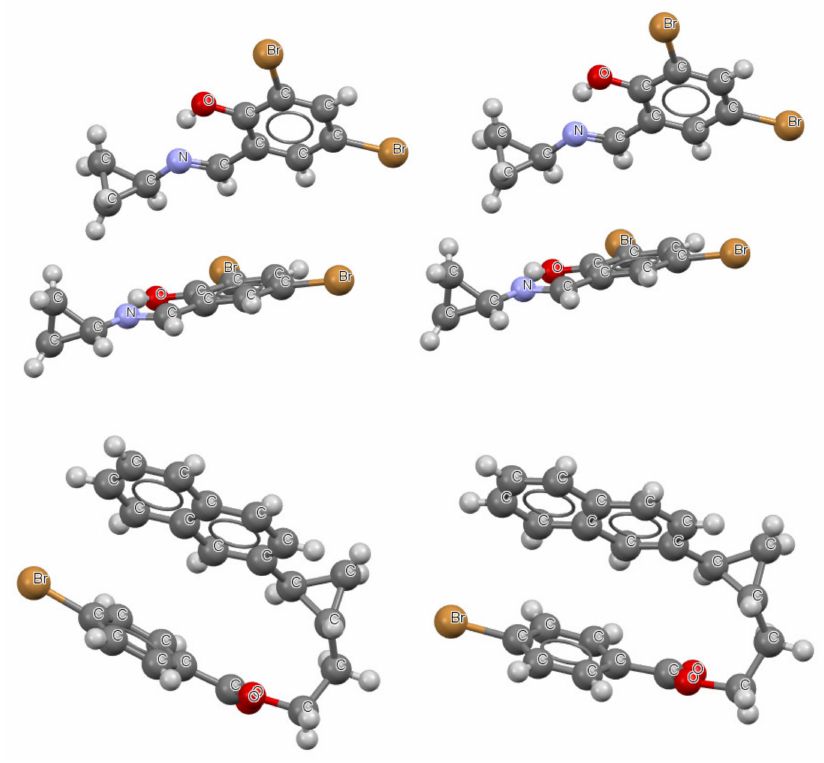
Figure 2. The fragments of the crystal structures of 2,4-dibromo-6-(cyclopropyliminomethyl) phenol (KIKLIA refcode, upper ) and 2-(2-(2-naphthyl)cyclopropyl)ethyl 4-bromobenzoate (SUTVOU refcode, below ); small grey circles correspond to